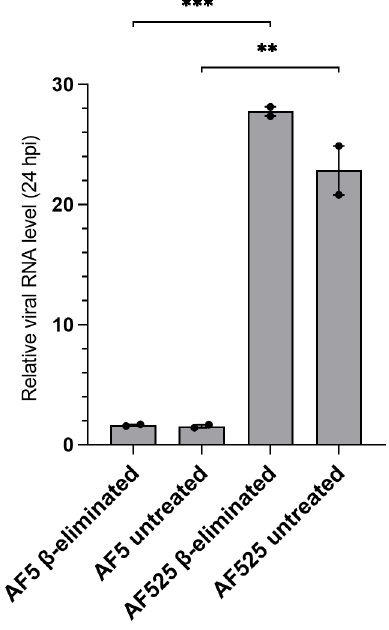
Figure 3. Relative viral RNA levels of SFV4-infected AF5 and AF525 cells treated with β -elimination reagents. Total RNA of SFV4-infected AF5 and AF525 cells was analyzed by RT-qPCR, using a standard curve, to determine viral RNA levels. Means with standard errors are shown for two independent experiments. Relative SFV4 amount was quantified using ribosomal S7 RNA as a housekeeper and normalized to untreated cells as control. *** indicates p ≤ 0.001; ** indicates p ≤ 0.01; Student t -test.